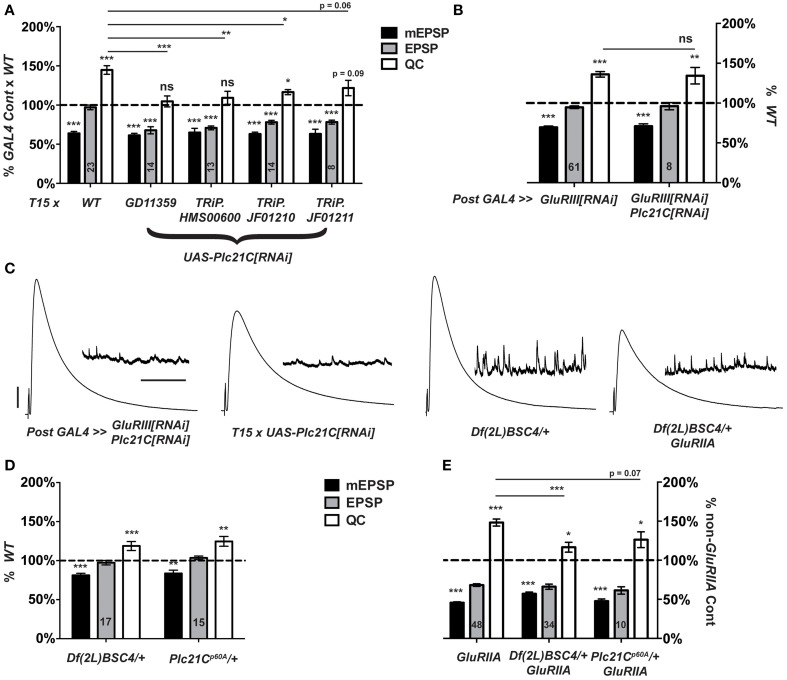
Presynaptic Plc21C is required for homeostatic compensation. (A)
T15-mediated RNAi knock down of Plc21C results in a failure to maintain the EPSP at control levels (***p < 0.001). Concerning homeostatic compensation, T15 × TRiP.JF01210 is the only cross to show increased quantal content compared to its GAL4 cross control (*p = 0.04), but even this quantal content was still significantly depressed compared to the T15 × WT control (*p < 0.05, One-Way ANOVA including all crosses in dataset, with Tukey's post-hoc). (B) Postsynaptic knock down of Plc21C does not affect homeostatic compensation: the EPSP is maintained (ns, p = 0.45) at control levels because the quantal content is upregulated (**p < 0.01). (C) Representative traces show normal neurotransmission upon postsynaptic knock down of GluRIII and Plc21C or a heterozygous loss of Plc21C via use of the deficiency chromosome Df(2L)BSC4. However, evoked release is not maintained upon T15-mediated knock down of Plc21C or the heterozygous loss of Plc21C in a GluRIIASP16 mutant background. (D) Evoked amplitudes (EPSPs) are unaltered upon heterozygous loss of Plc21C by use of the deficiency Df(2L)BSC4 or Plc21Cp60A allele though both do show a small, yet significant decrease in the amplitude of mEPSP events (***p < 0.001 and **p < 0.01, respectively). (E) Quantal content is minimally increased in the GluRIIASP16 background upon heterozygous loss of Plc21C compared to their respective genetic controls (*p < 0.05). For the Df(2L)BSC4 deficiency, the increased quantal content does not reach the level of increase found in GluRIIASP16 (***p < 0.001, One-Way ANOVA, Tukey's post-hoc). This is indicative of a partial impairment in homeostatic compensation. Scale bars for EPSPs (mEPSPs): 5 mV (1 mV); 50 ms (2000 ms).